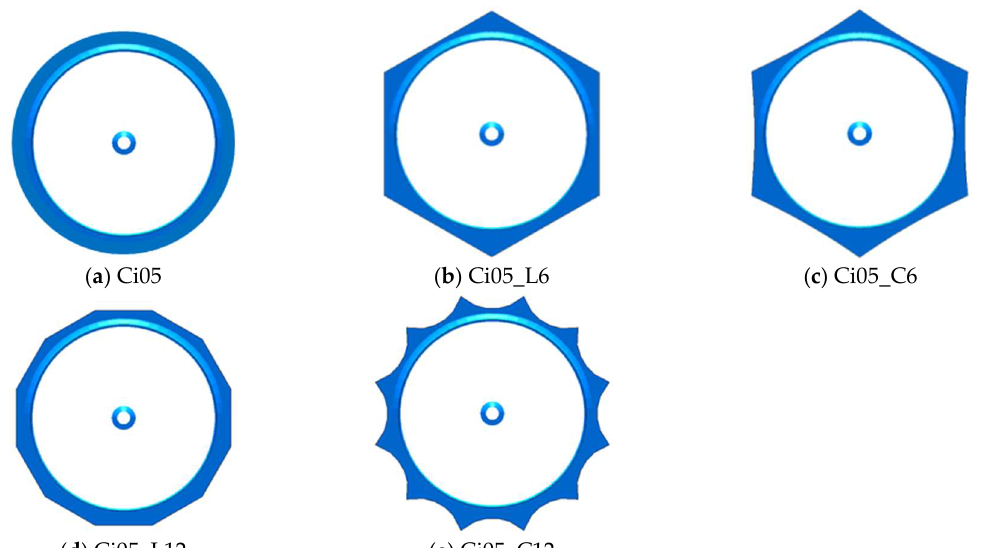
Figure 8. Computational grid and conditions: ( a ) The computational domain; ( b ) The boundary conditions; ( c ) The grid near the WLT (Ci05).